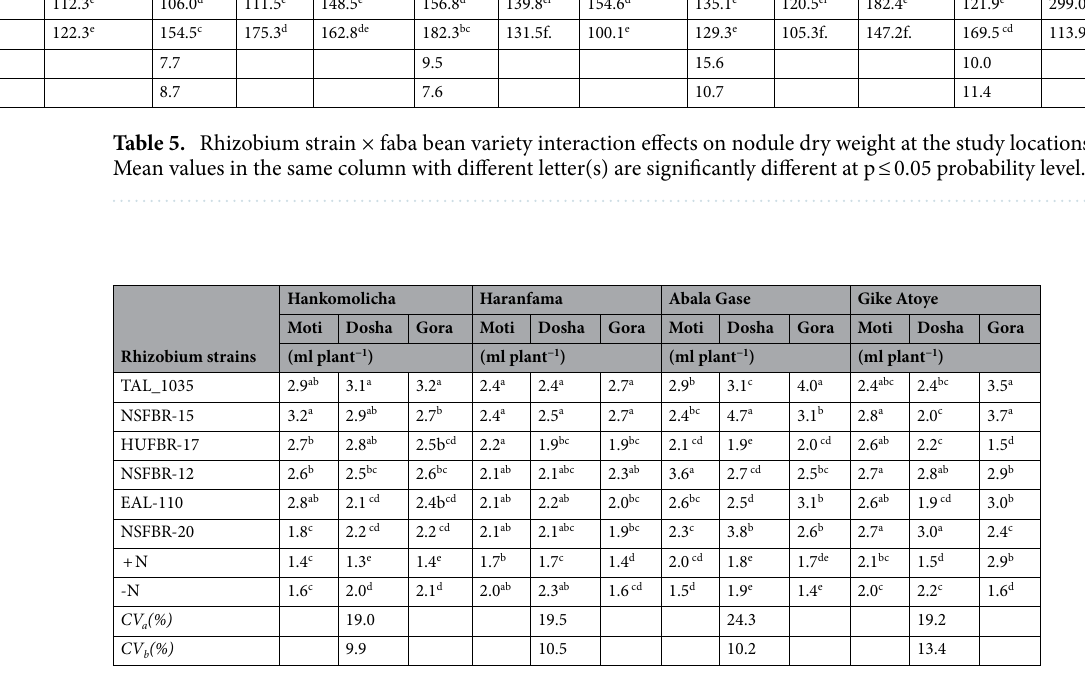
Table 6. Rhizobium strain x faba bean variety interaction effects on nodule volume at the study locations. Mean values in the same column with different letter(s) are significantly different at p ≤ 0.05 probability